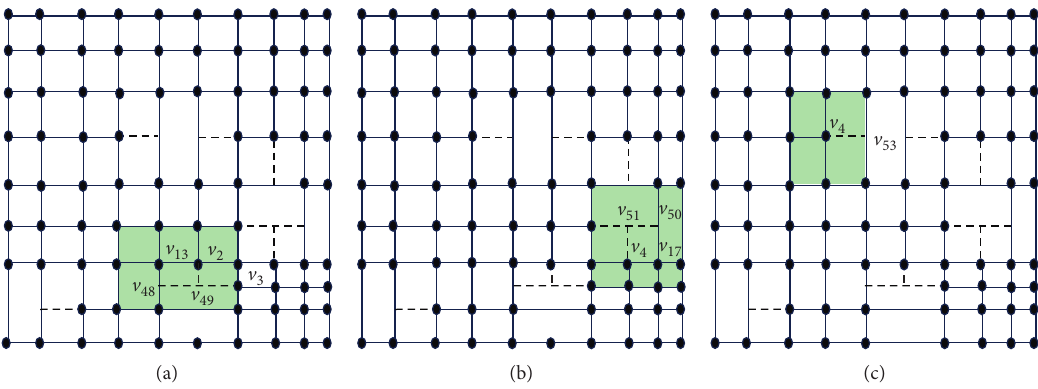
Figure 4: The support meshes of three basis vertices v